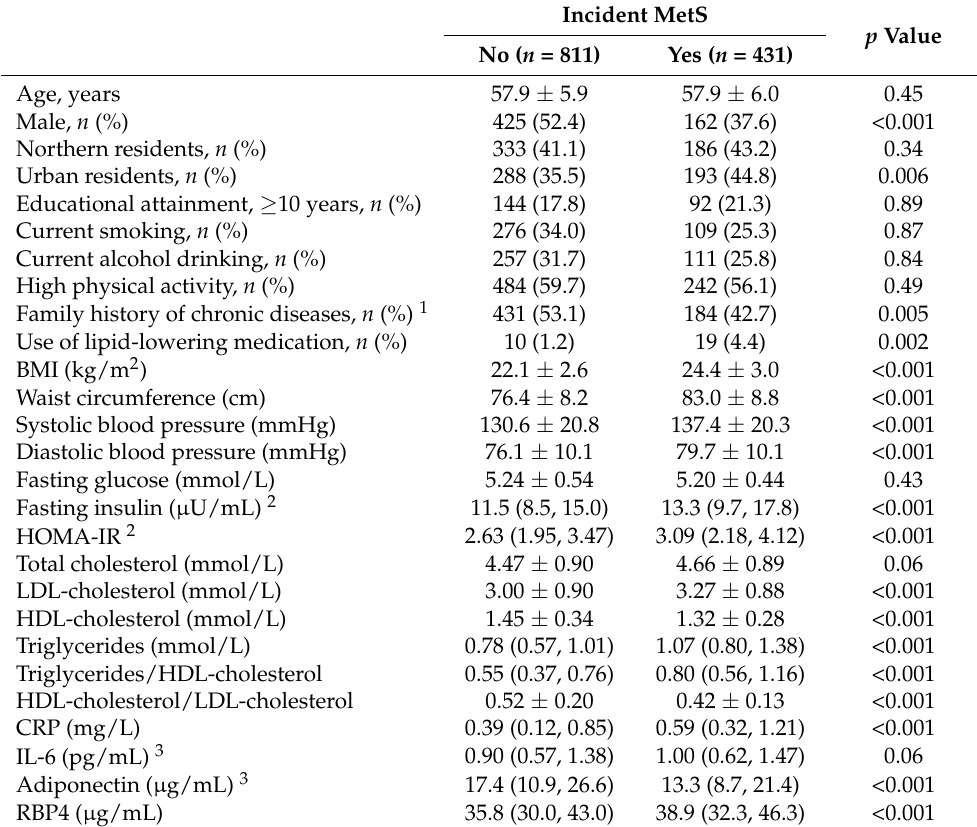
Table 1. Baseline characteristics of study population between incident MetS cases and